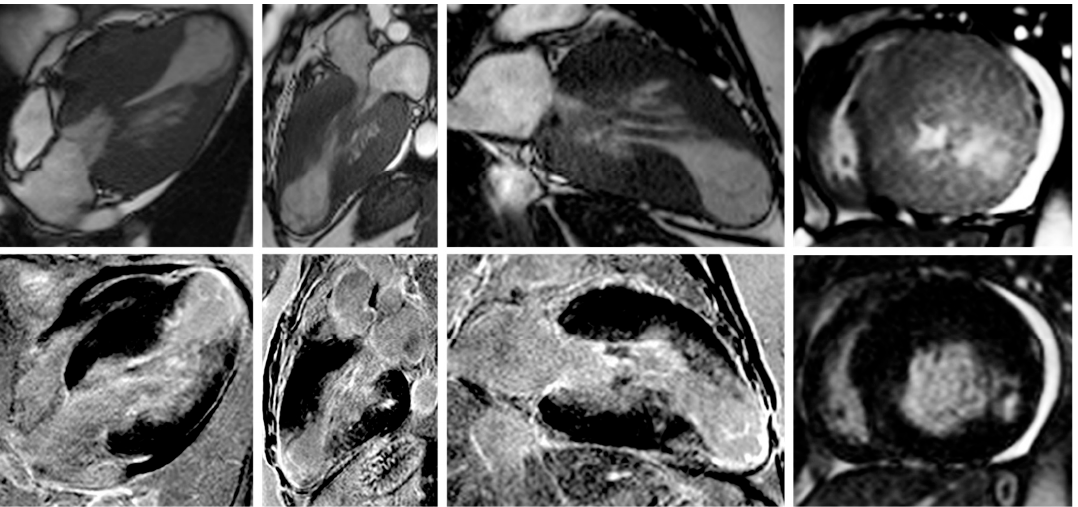
Figure 4. Contrast-enhanced CMR in a 50-year-old female patient with a history of hypertrophic cardiomyopathy with LV apical aneurysm (from the own collection of the authors). ( Upper row ): b-SSFP cine images in four, three and two chambers, and short axis, respectively. The LV is dilated (110 mL/m2) with severely impaired systolic function (LVEF 25%). There is asymmetrical LV hyper- trophy with a maximum wall thickness of 28 mm at the level of the interventricular septum. Note the large apical aneurysm with a maximum diameter of 40 mm and thin walls. ( Lower row ): LGE imaging shows transmural fibrosis of the LV apical aneurysm and a small focal intramyocardial scar at the level of the basal infero-lateral wall. The total percent of fibrosis is 16% of the LV myocardium. No thrombus is seen inside the apical aneurysm. Abbreviations: b-SSFP, balanced steady-state free precession; CMR, cardiac magnetic resonance imaging; LVEF, left ventricle ejection fraction; LGE, late gadolinium enhancement; LV, left